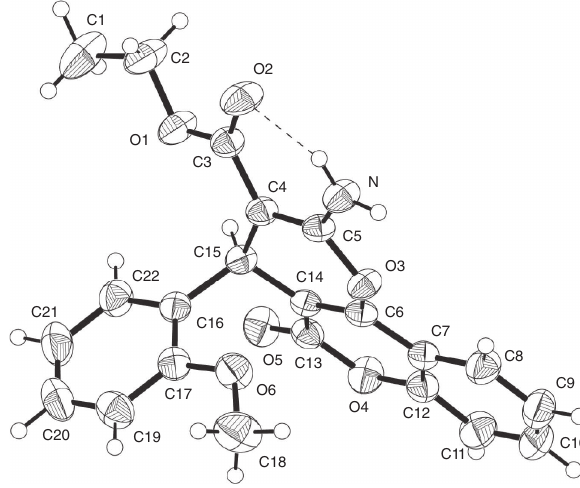
Table 1: Data collection and handling.